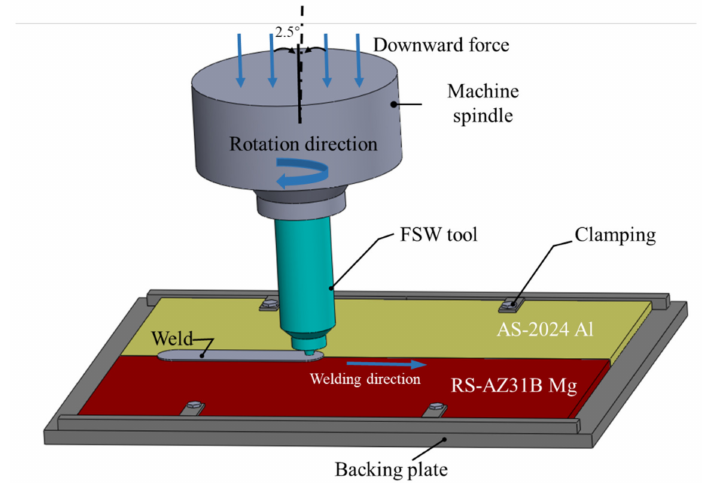
Figure 1. Schematic diagrams of Al/Mg FSW experimental set-up. Table 1. Nominal composition and mechanical properties of base materials.